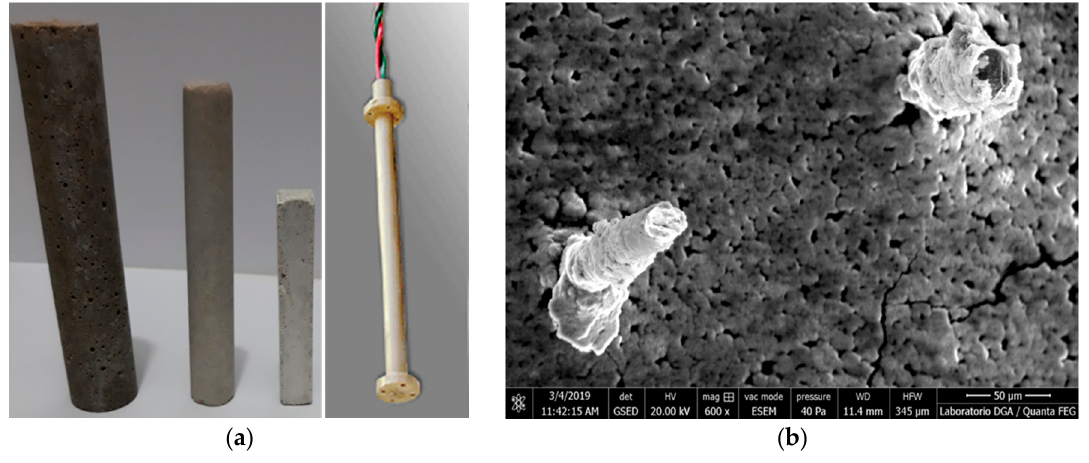
Figure 1. ( a ) MMCC sensors with an embedded microwire, and a strain gauge. ( b ) Electronic micrograph of the two embedded microwires.